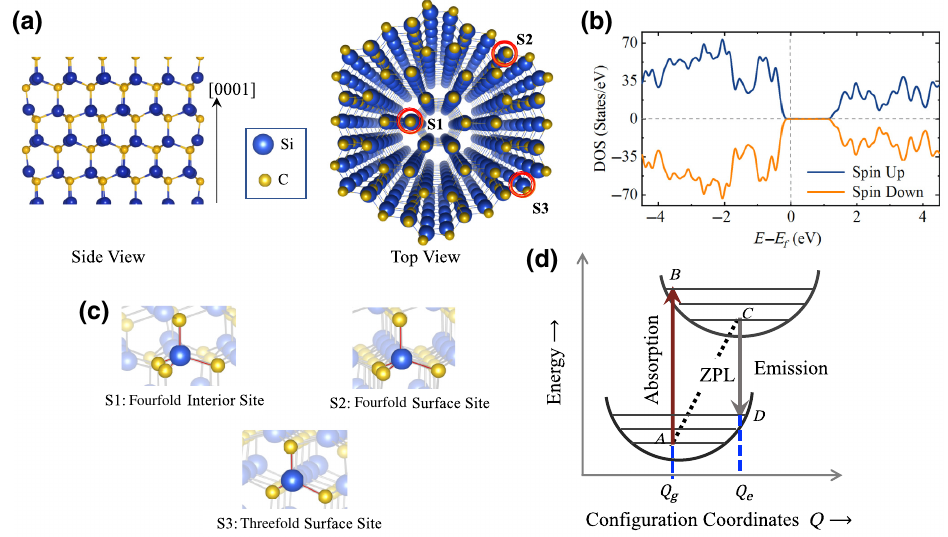
FIG. 1. The 2H-SiC nanowire. (a) Side and top views of pristine and/or defect-free NW, periodic along the [0001] direction. (b) The spin-resolved density-of-states (DOS) plot for the pristine NW, showing that it is nonmagnetic. (c) The three distinct silicon sites [circled in (a)] at which the defects are created: the tetrahedrally bonded interior site (S1), the fourfold-coordinated surface site (S2), and the undercoordinated site on the surface, bonded to only three carbon atoms (S3). (d) The configuration coordinate diagram, giving the total energy as a function of the ground- (bottom) and excited-state (top) configurations within the Franck-Condon picture. It is used to emulate the photoexcitation process, which is calculated using the constrained-occupation DFT (CDFT)